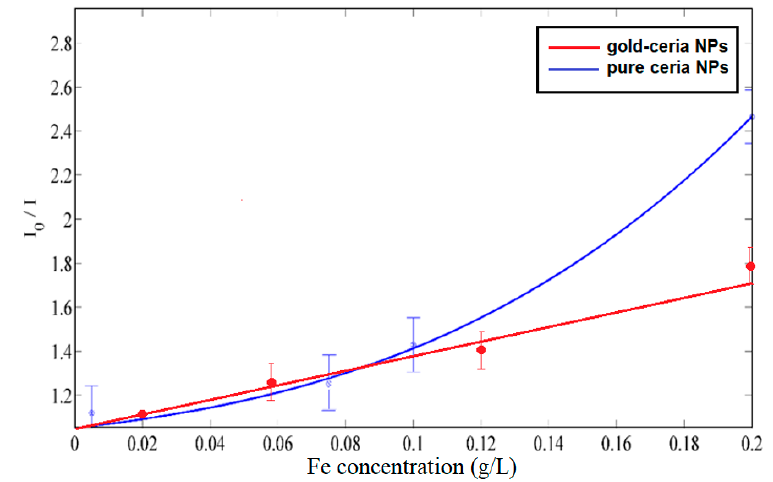
Figure 7. Relation between relative fluorescence intensity peak and variation of iron tiny particle concentrations for both gold-ceria nanoparticles and pure ceria nanoparticles “as a control sample”.